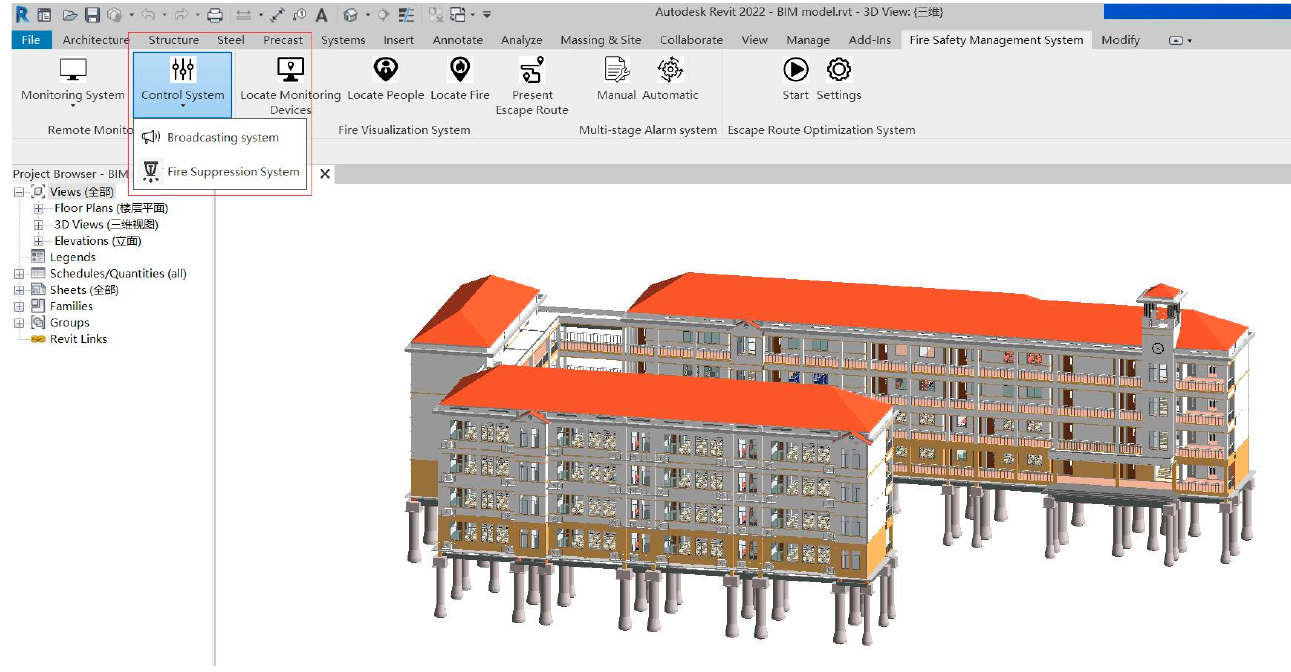
An example of the control system add-ins is shown in Figure 5.